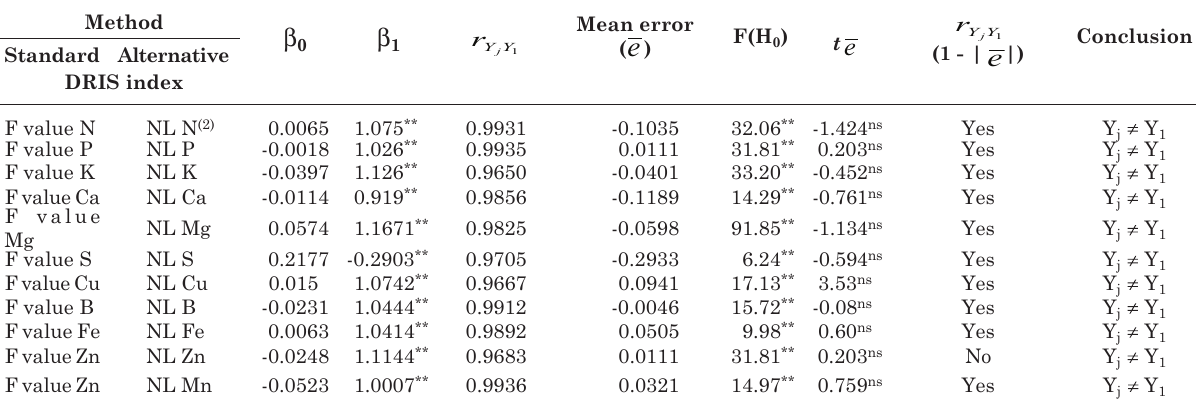
table 1. Results of the identity test (1) of the analytical models ( Y1Yj )